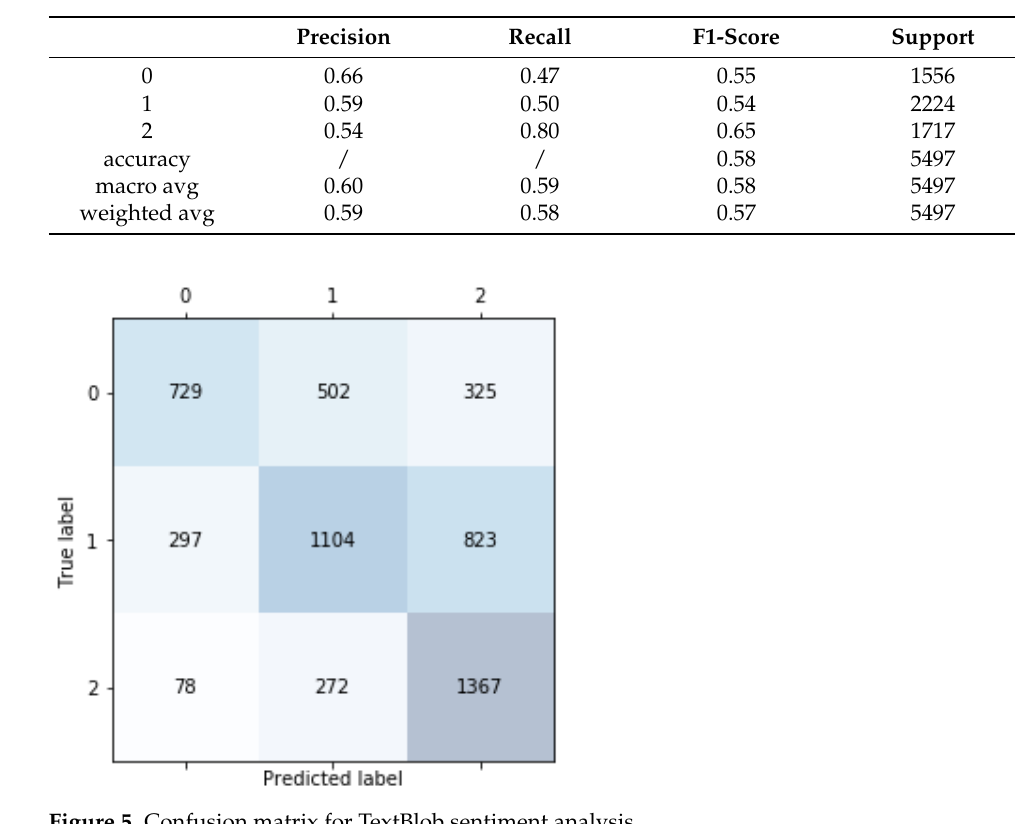
Figure 5. Confusion matrix for TextBlob sentiment analysis.